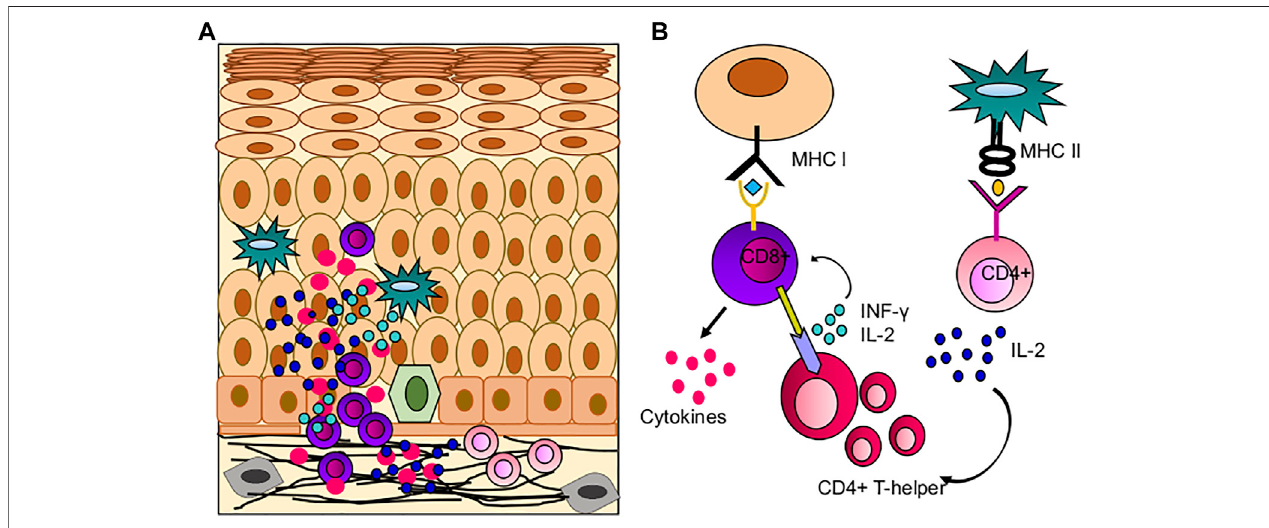
FIGURE4| RoleofimmunecellsinOLPpathogenesis; (A) Immune in fi ltrationinOLP,CD8 + Tcellsmediatedhyperimmuneactivationleadingtoapoptosisofbasal keratinocytes. (B) Possible mechanism of hyperimmune response in buccal mucosa, where CD8 + T cells are activated by oral keratinocytes and CD4 + T cells.